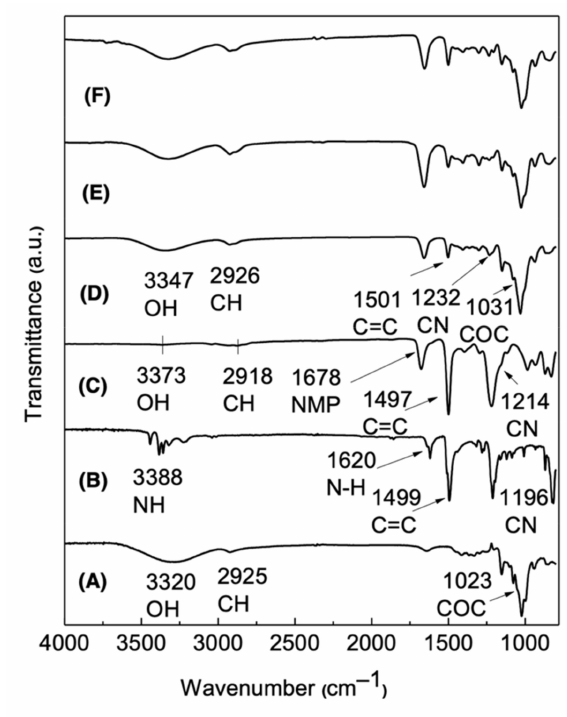
Figure 1. FTIR spectra of ( A ) α -CD, ( B ) ODA, ( C ) ODA-PHA, ( D ) α -CD/ODA-PHA, ( E ) β -CD/ODA- PHA, and ( F ) γ -CD/ODA-PHA. Among the three CDs, α -CD was used to compare the band positions of polymer composites.